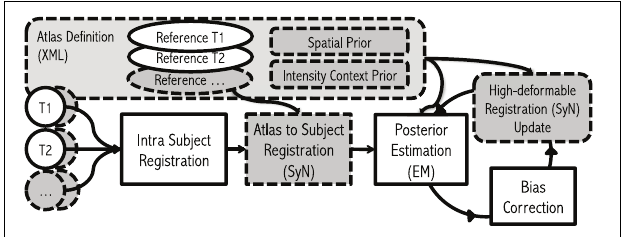
multiple times. Gray dashed boxes represent where our